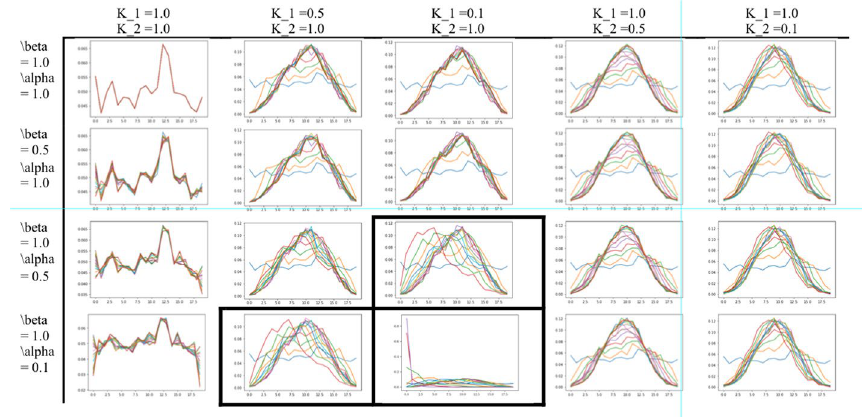
Fig. 5 Sensitivity analysis in the open boundary. The random seeds, based on a uniform distribution, were set to obtain the same initial arrays. Subfigures in lines show variations in the scale parameters, and columns show variations in the size parameters. Different colors in each plot represent iterations, starting from a uniform distribution. The model validation uses the parameters K 1